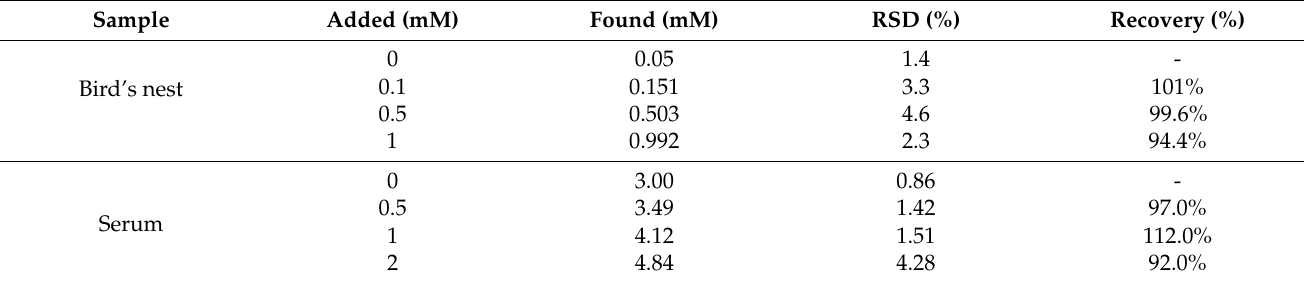
Table 2. Determination of SA in bird’s nests and serum samples using the 4-MPBA-AuNPs@PEG 400 sensing system.